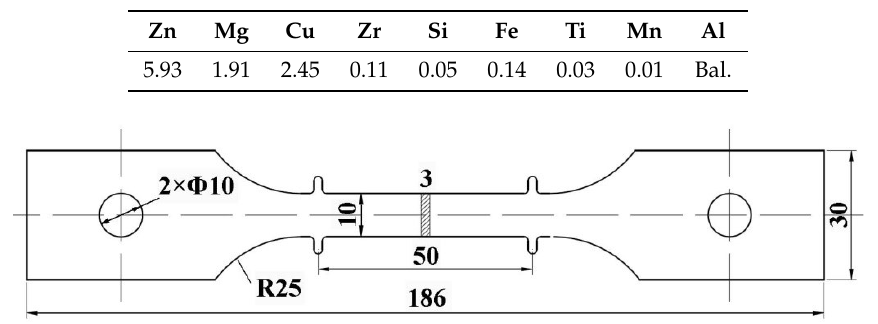
Figure 1. Geometry and dimensions of creep aging test specimens (unit: mm).